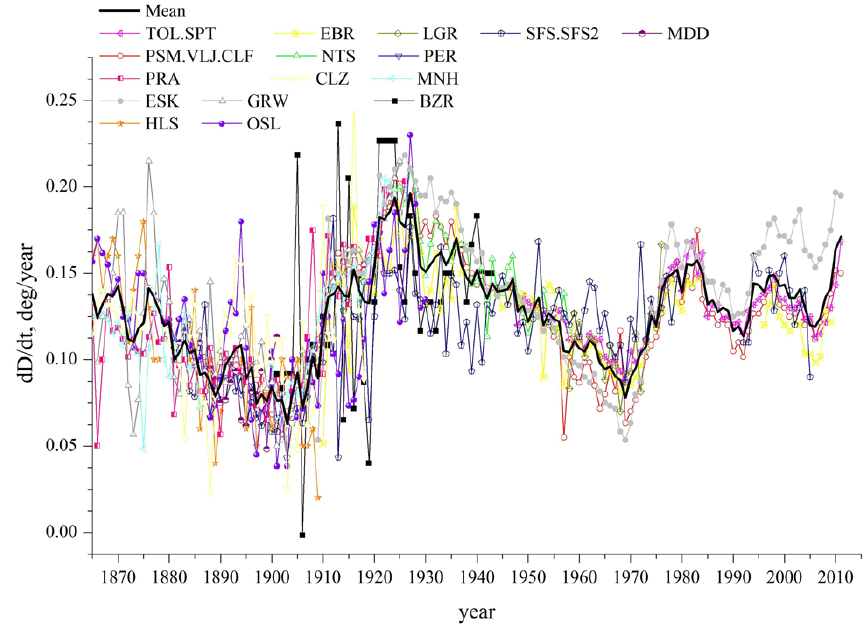
Fig. 9. First derivatives (SV) of 16 reference series from different stations (lines with dots of different form and colour) and their mean – RS obs – D .